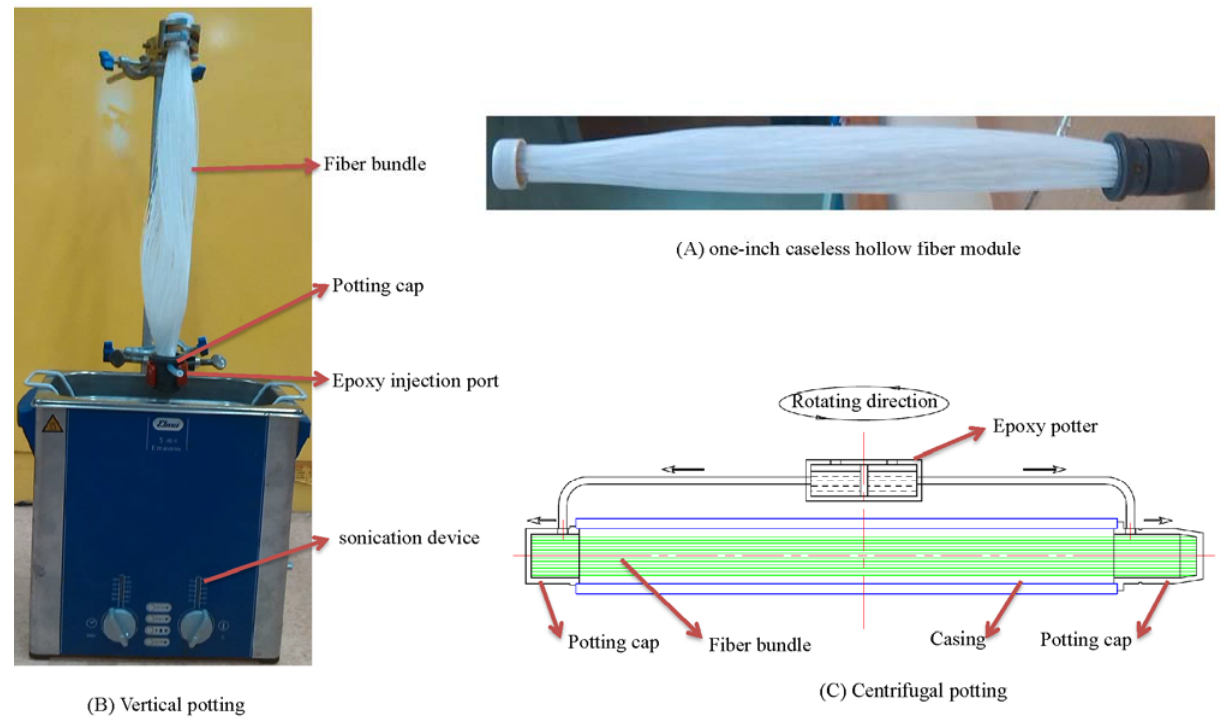
Figure 1. Vertical potting vs . centrifugal